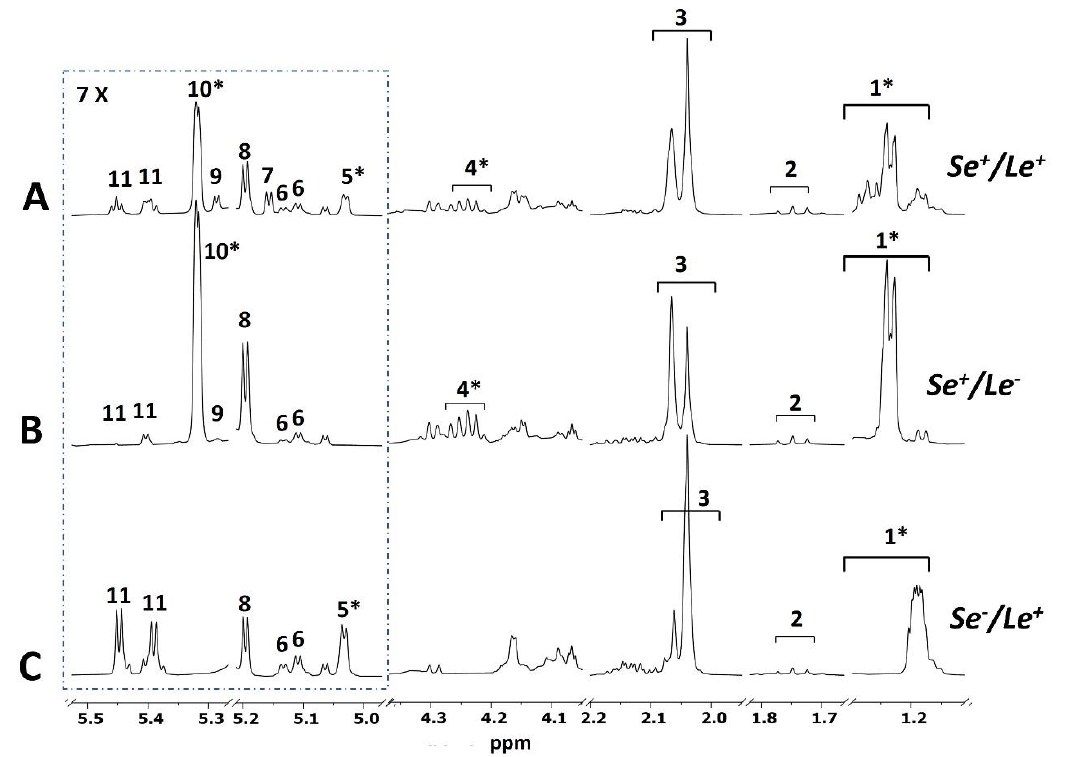
Figure 1. Expanses of representative 1D NOESY-presat 1 H NMR spectra (500 MHz, 300 K) of pre- term human milk (350 μL of filtered milk, 250 μL of 0.1 M PBS in D 2 O, pH 7.4 and 50 μL of 30 mM